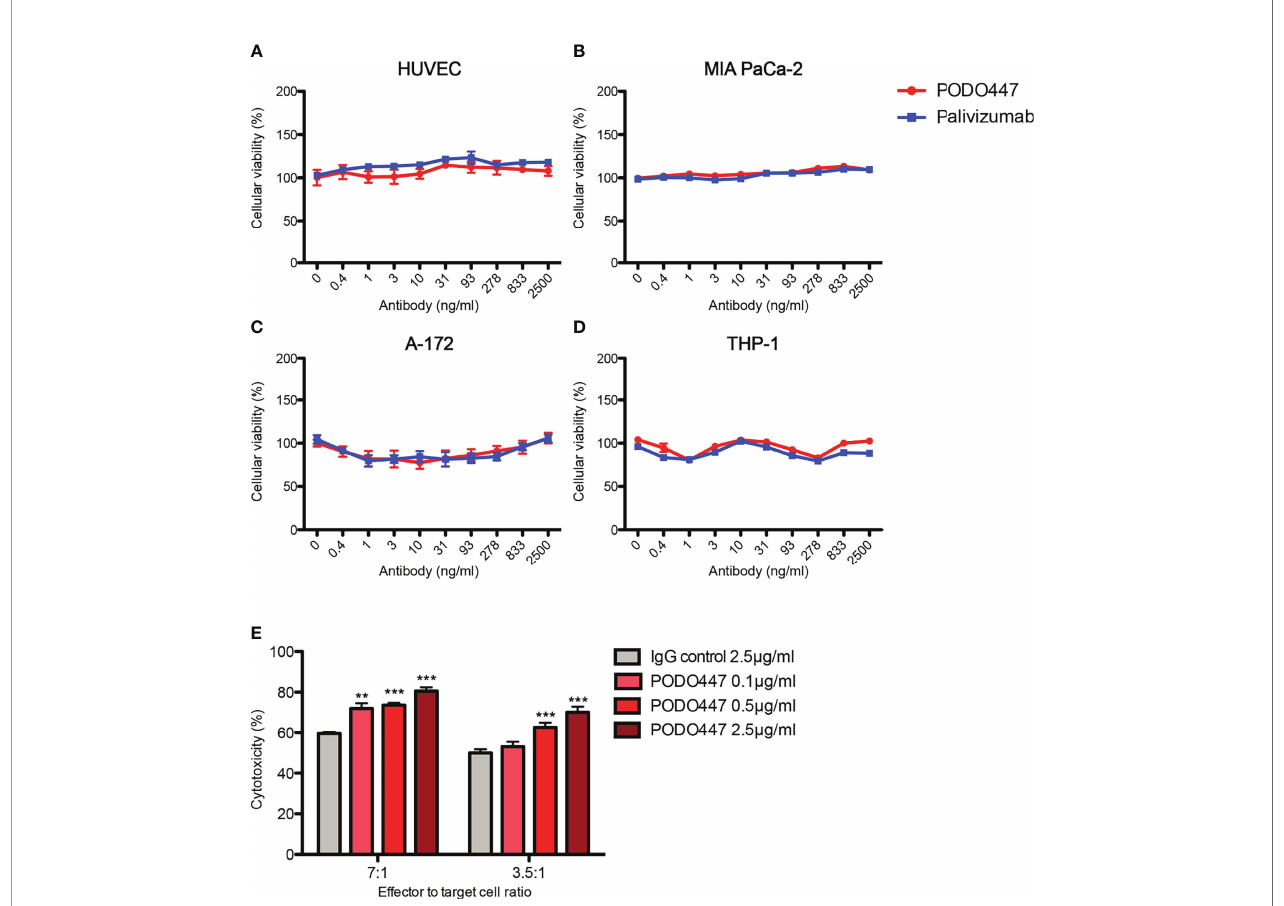
FIGURE 2 | Unconjugated PODO447 lacks inherent cytotoxic activity but induces ADCC. Cytotoxic effect of unconjugated PODO447 and palivizumab control Abs on (A) human umbilical vein endothelial cells (HUVEC), (B) pancreatic ductal adenocarcinoma (MIA PaCa-2), (C) glioblastoma (A-172) and (D) acute monocytic leukemia (THP-1) cell lines as determined by MTT assay; and (E) antibody-dependent cellular cytotoxicity induced by PODO447 in A-172 cells after 1 hr co- incubation with human PBMCs at a 7:1 and 3.5 ratio of effector (PBMCs) to target (A-172) cells. ADCC-induced cellular toxicity was determined by fl ow cytometry. **p < 0.01, ***p <